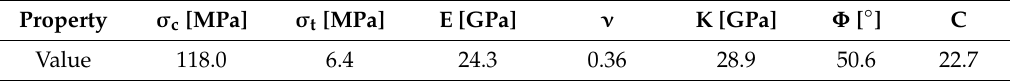
Table 1. Material properties of Coconino sandstone.